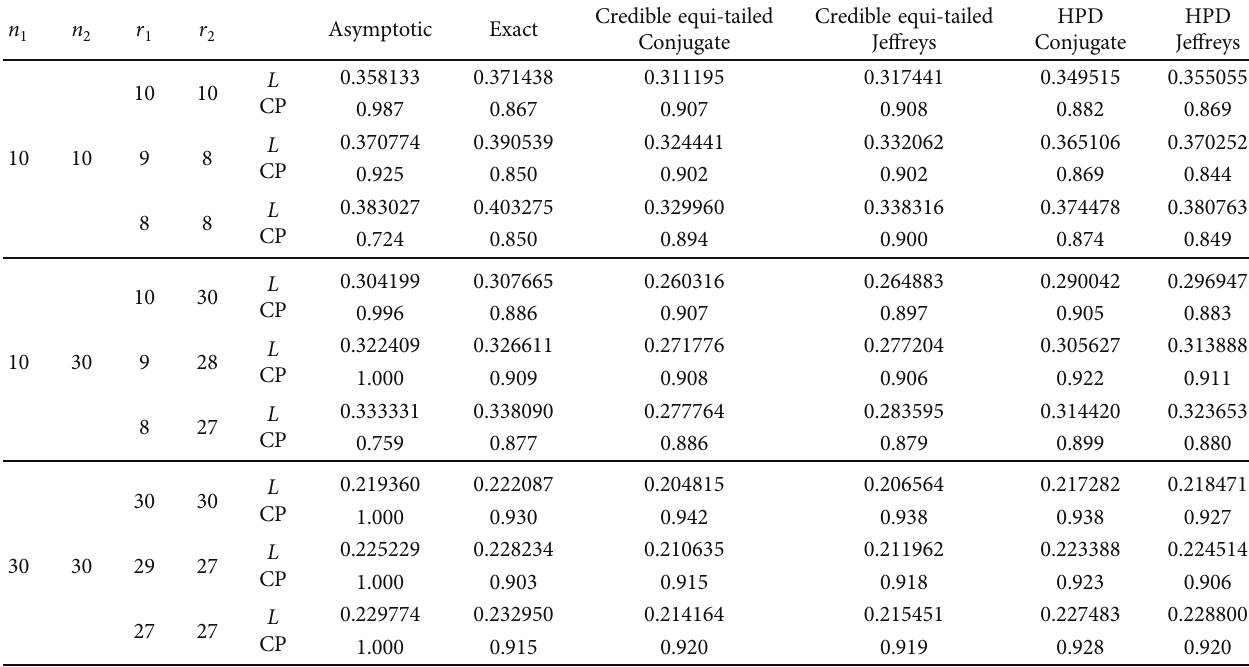
= 1, β = 2 and γ = 1 . 1 2